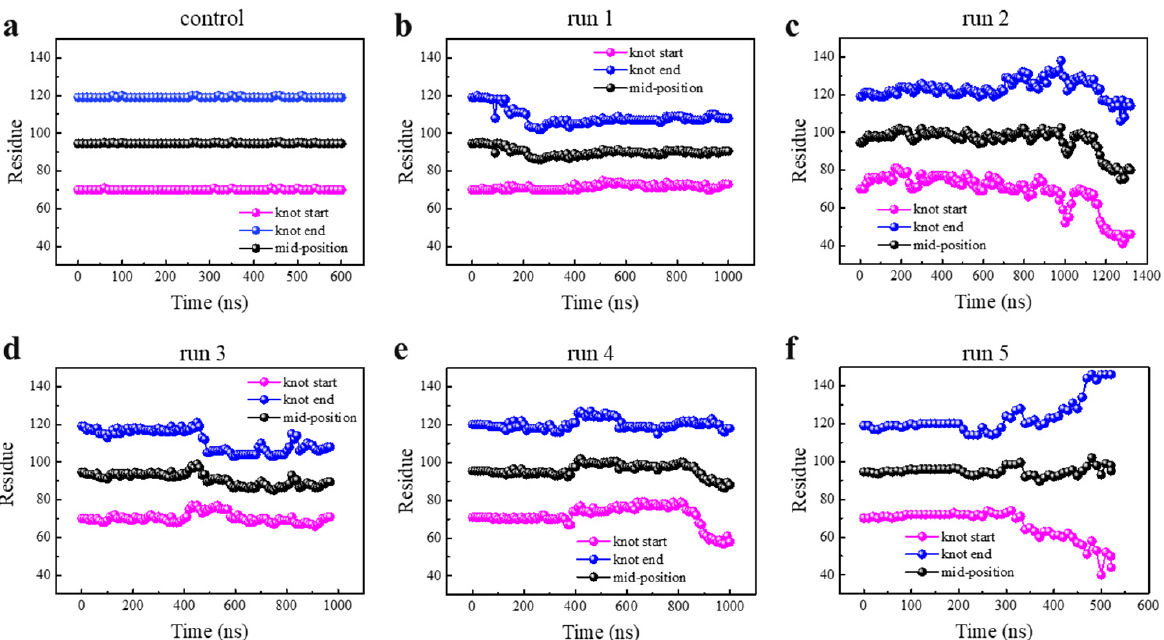
Figure 2. Sequential movement of two knot termini and the corresponding mid-position for YbeA under the normal (T = 300 K, ( a )) and thermal denaturing (T = 520 K, ( b – f )) conditions. Five independent simulation runs were performed under the same enhanced thermal denaturing conditions.